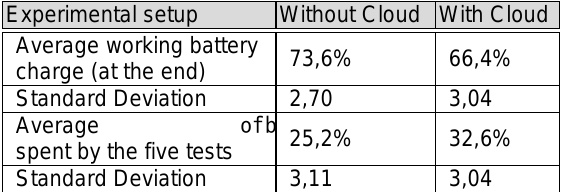
Table 3. CPU Load with and without cloud